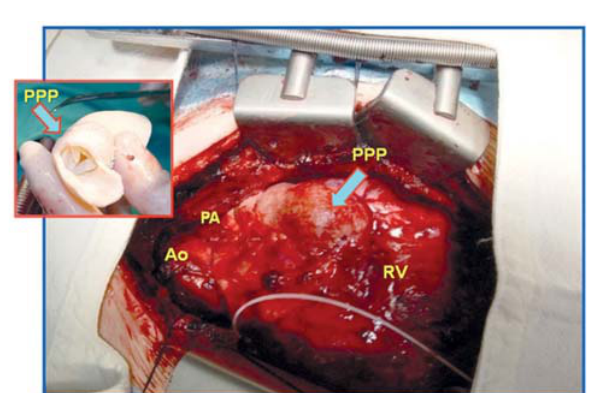
Fig. 4 - Surgical image shows: patient off cardiopulmonary bypass, porcine pulmonary prosthesis (PPP) implanted for right ventricular remodeling. Ao = aorta; PA = pulmonary artery; RV = right